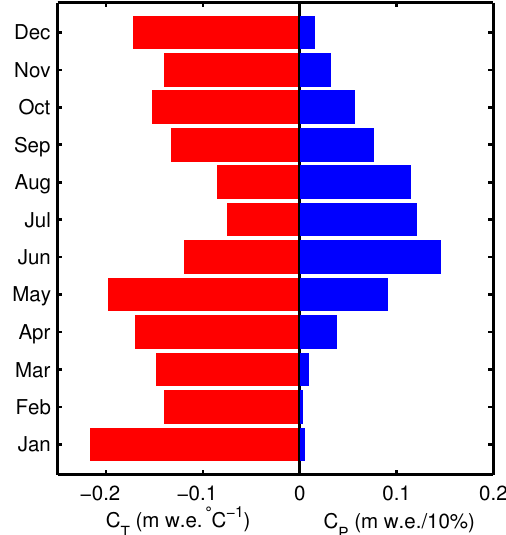
Fig. 7. Seasonal sensitivity characteristic, showing the sensitivity of the mass balance to changes in temperature ( C T ) and precipita- tion ( C P ) in a specific month. Changes in precipitation are relative, shown is the change in mass balance after a 10% change in monthly precipitation. Mass balance is calculated for the glacier geometry of the modelled equilibrium state with b ref